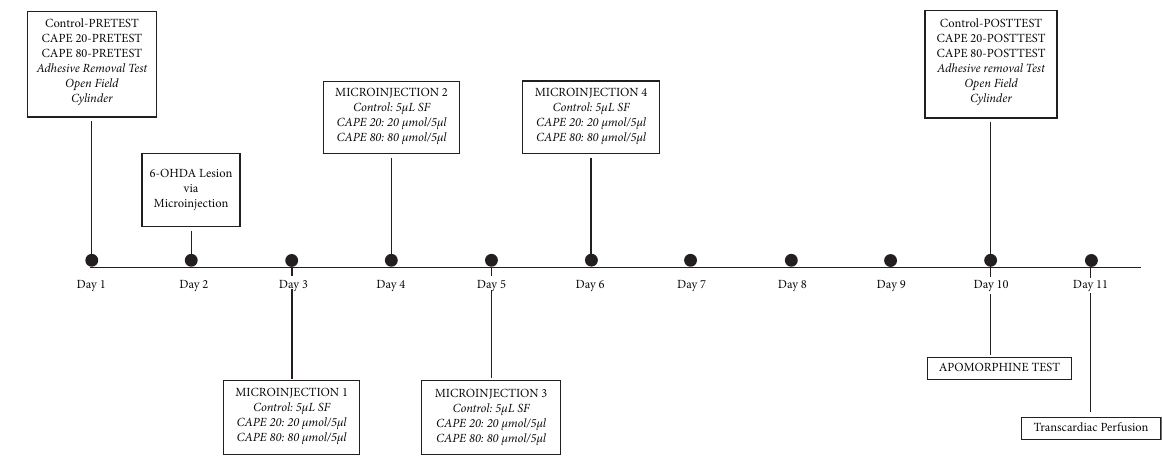
Figure 1: The experimental